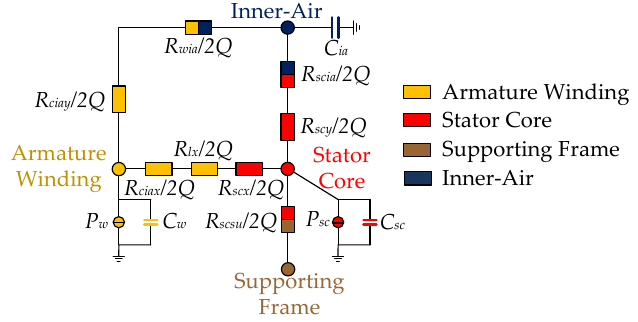
Figure 6. Simplified thermal model of the segmented stator.